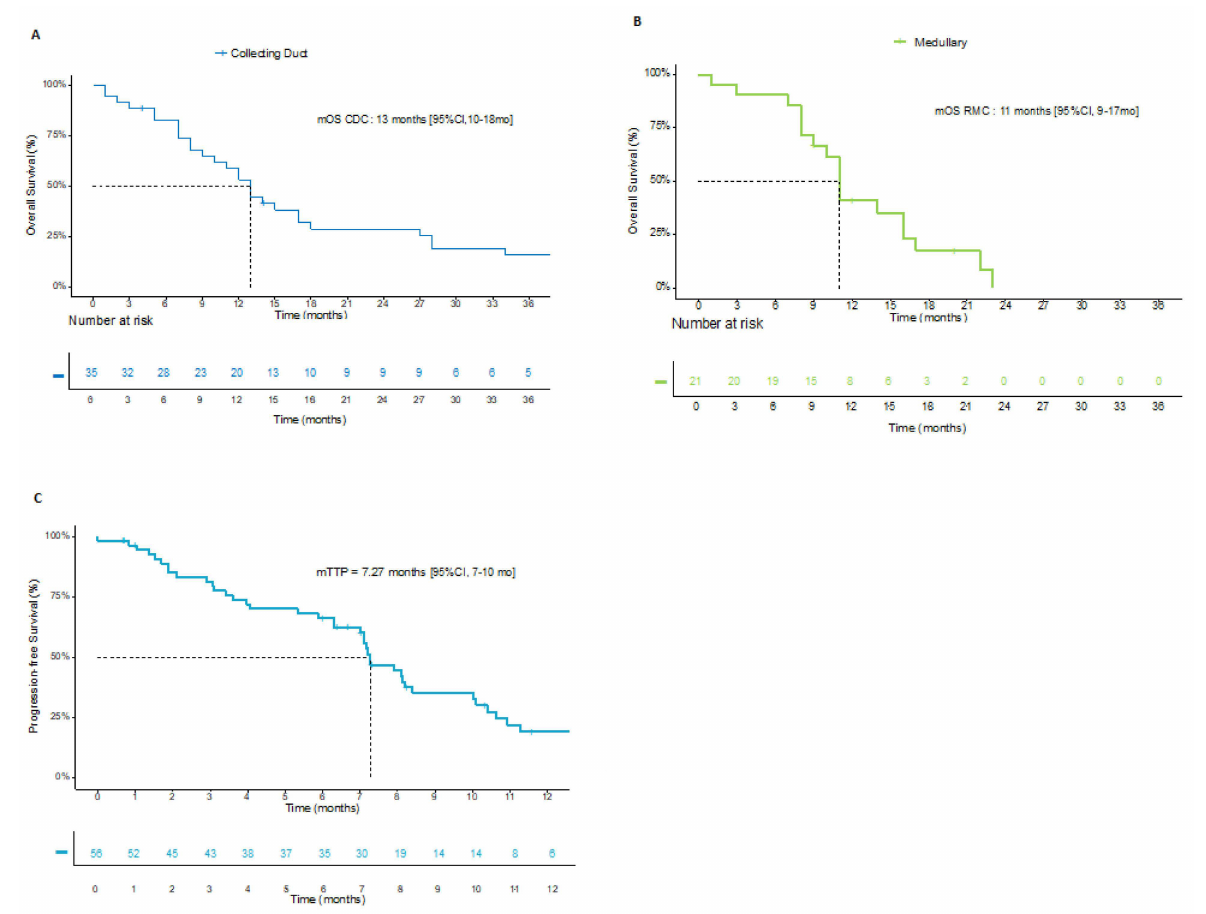
Figure 1. Survival curves ( A ) OS since metastatic stage in patients with CDC; ( B ) OS since metastatic stage in patients with RMC; ( C ) TTP in first line.